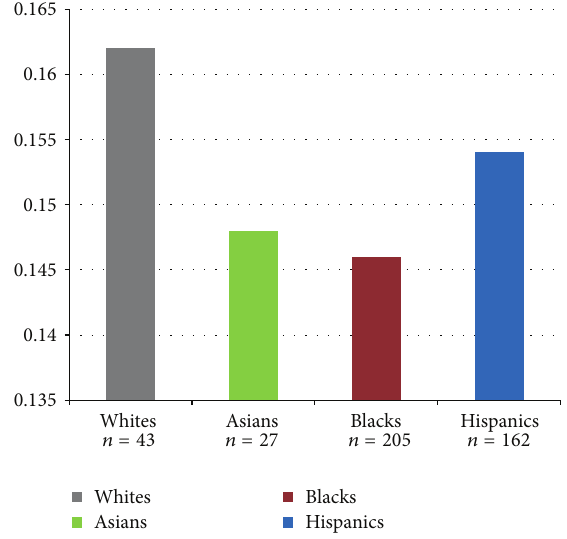
Figure 2: Prevalence of gastric intestinal metaplasia in different ethnic